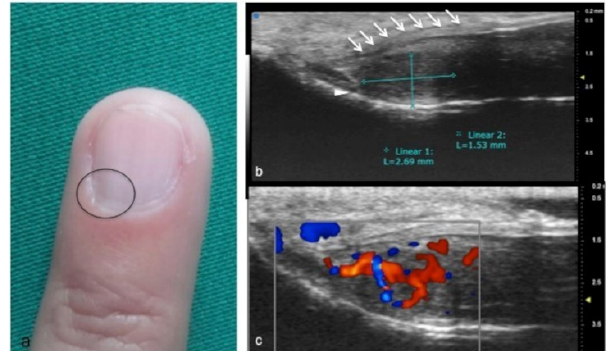
Figure 12. Glomus tumor in the subungual space. No clear alterations were visible during clinical examination at the site of pain (circle in ( a )). In ( b ), UHFUS effectively demonstrates the presence of a hypo-isoechogenic nodule (calibers) in contact with the adjacent phalangeal bone (arrowhead) under the nail plate (arrows). Note the small deformation of the nail plate. Mild vascularization on color Doppler was present ( c ).